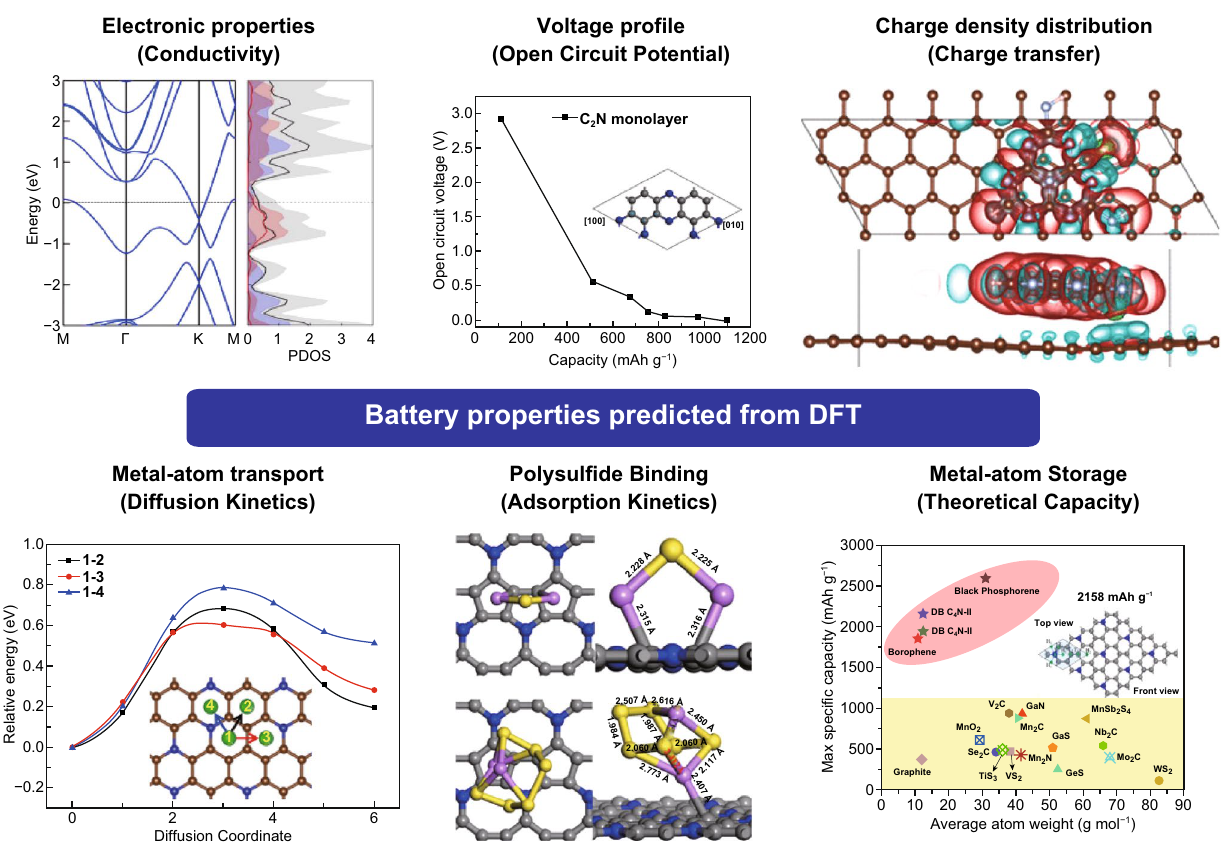
Fig. 6 Electrochemical properties of carbon nitrides can be predicted from DFT calculations. Reproduced with permission from [27, 37–40]. Copyright permissions from Elsevier, American Chemical Society, Wiley–VCH, and IOP Publishing. (Color figure